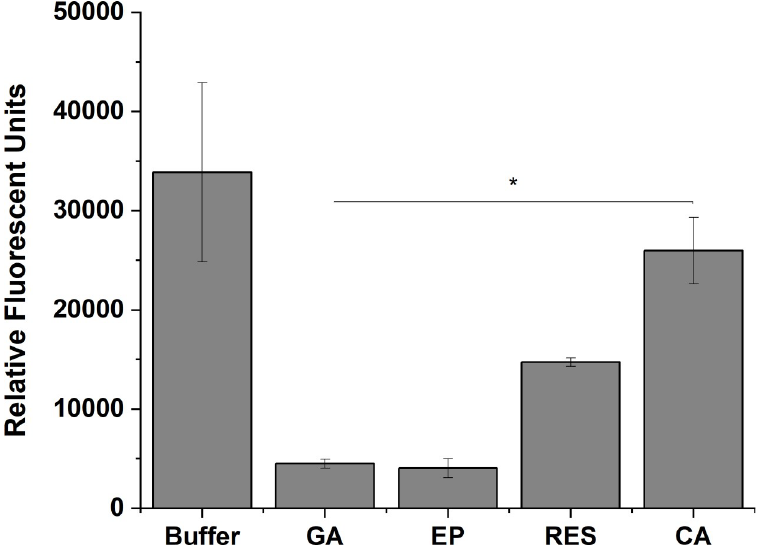
Fig 5. Phenolic compounds bind to X . fastidiosa lipopolysaccharide. Binding of compounds to LPS was quantified using the relative florescence of FITC-LPS bound to Polymixin B agarose beads after 1-hr incubation with buffer, gallic acid (1000 μ g/ml), epicatechin (200 μ g/ml), resveratrol (15 μ g/ml), or coumaric acid (60 μ g/ml). Data are expressed as means ± standard deviation of three independent experiments (n = 4 replicates per experiment). Significant differences (p-value < 0.001) in relative florescence determined by One-way ANOVA followed by Dunnett’s test comparing treatments to the buffer control are indicated by asterisk.